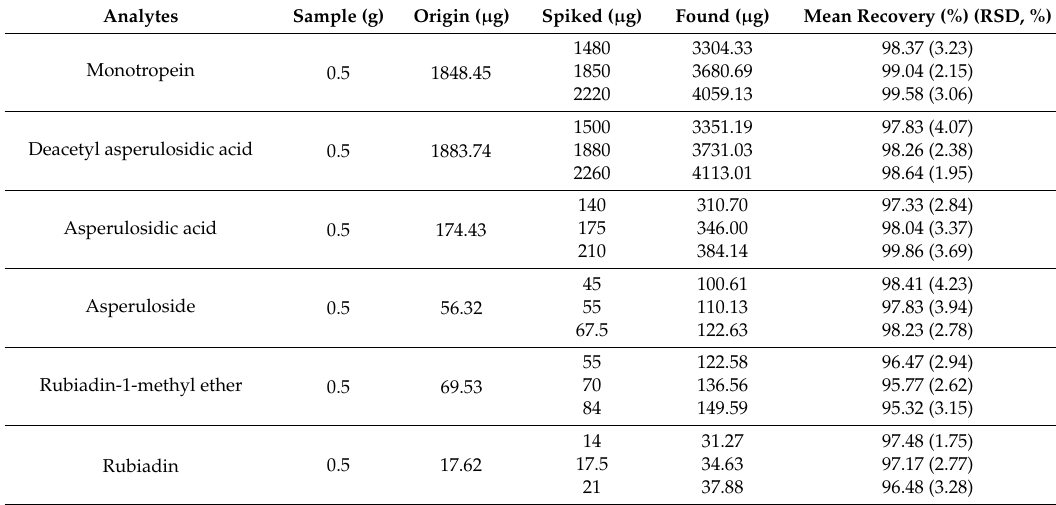
Table 3. Recoveries of the six